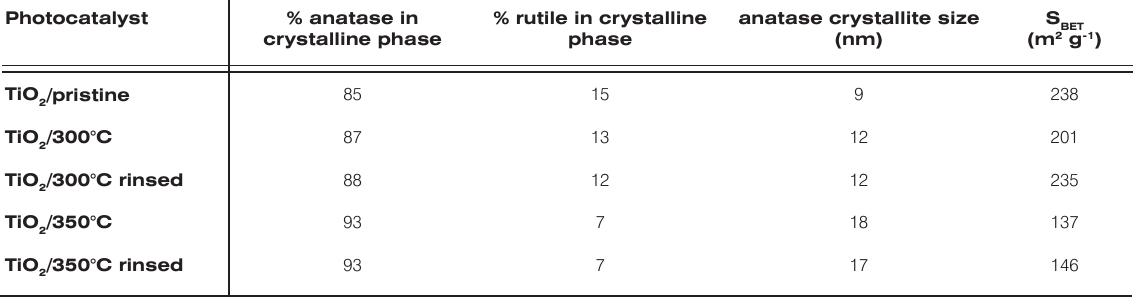
Table 1. Phase composition, crystallite size and specific surface area of studied samples.